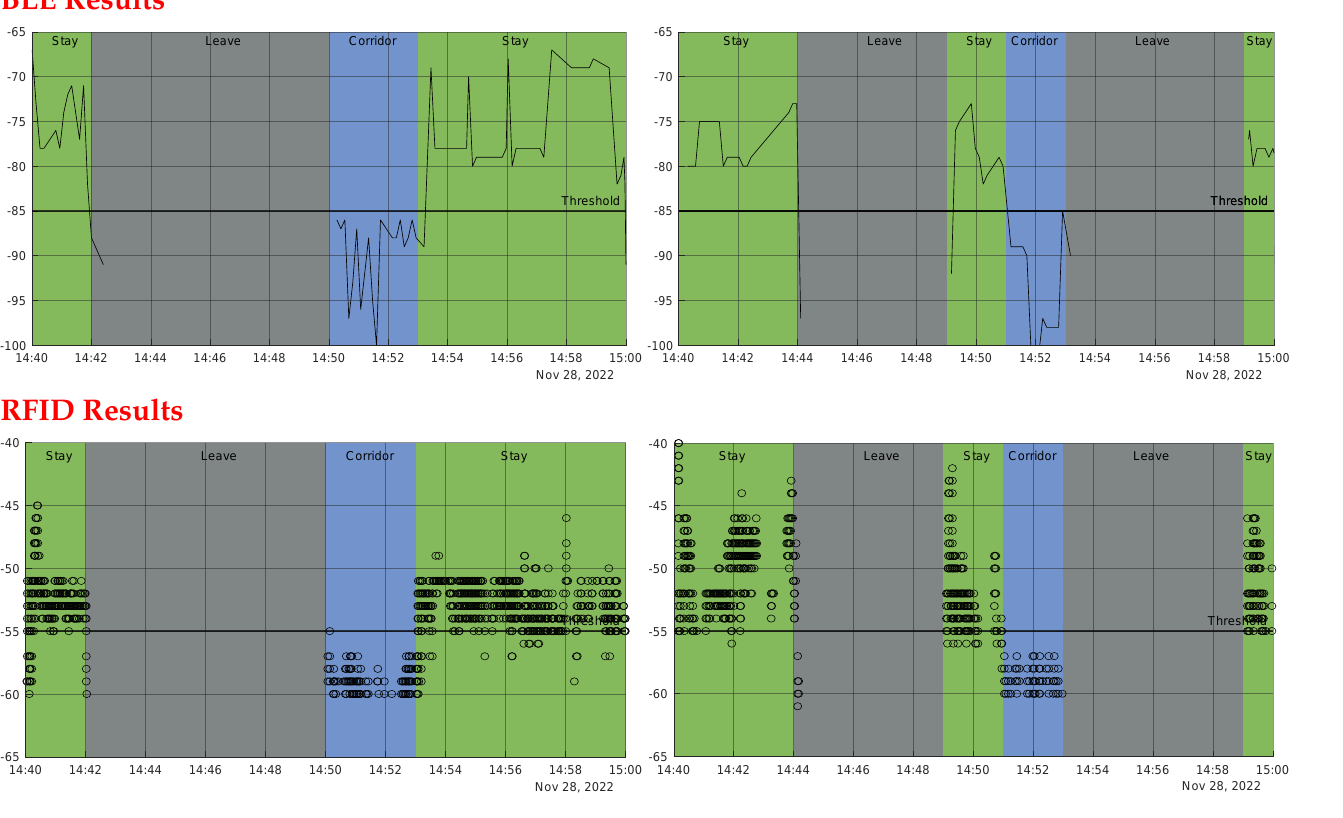
Figure 24. A random experiment replicating a real-life scenario in which two tagged people with tags on were required to spend their typical day in the office for 20 min. The first row shows the results of the BLE system, and the second row shows the results of the RFID